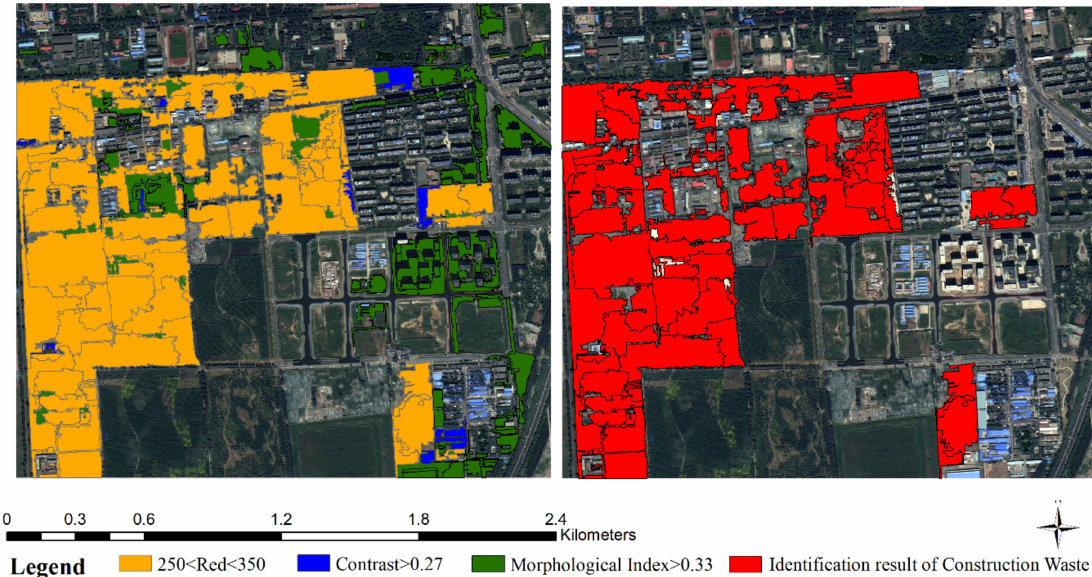
Figure 23. Construction waste identification and extraction results for study area B.